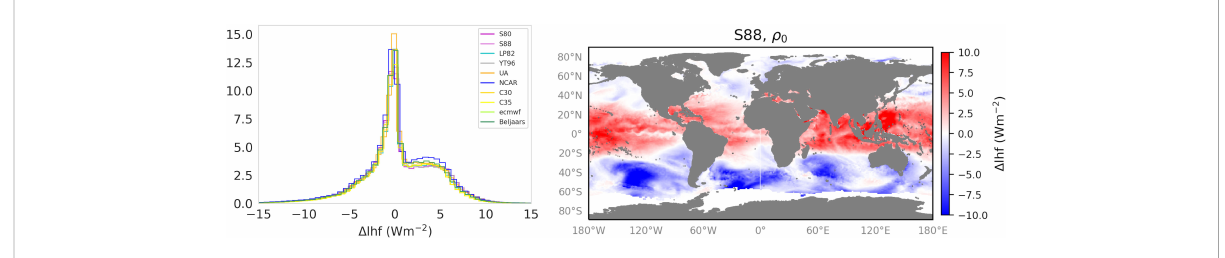
FIGURE 4 The impact of formulating the density of air ( r 0 ) as a constant rather than a function (see Tables S1, S10). Left: histograms of the difference in latent heat fl ux, D lhf= lh ffunction -lh fconstant (Wm – 2 ) for the ten parameterizations in AirSeaFluxCode. Right: the global distribution of this difference using the S88